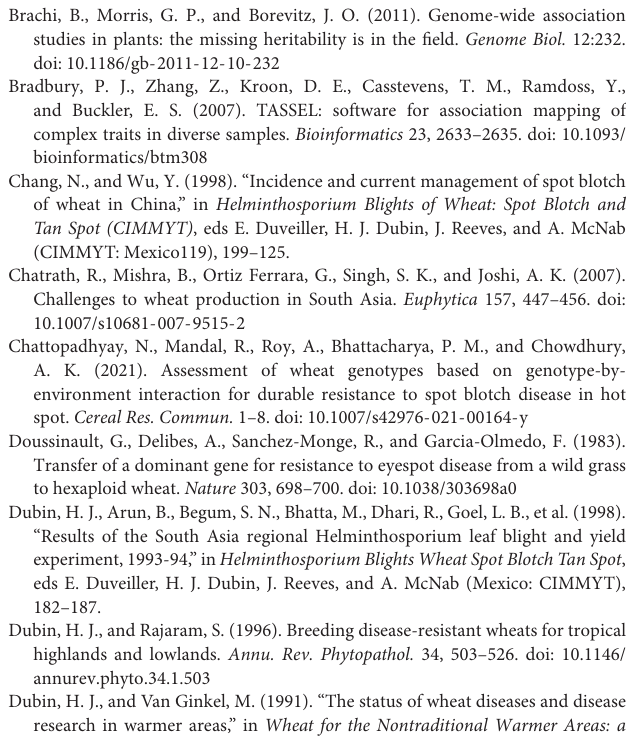
Supplementary Figure 1 | Manhattan plots showing the marker − log 10 p -values and the chromosomal positions for the marker-days to heading associations in genome-wide association mapping in seven panels. The blue line indicates the threshold of 0.001 to declare the significance of markers and selected markers that were significantly associated with days to heading are indicated. Supplementary Figure 2 | Manhattan plots showing the marker − log 10 p -values and the chromosomal positions for the marker-height associations in genome-wide association mapping in seven panels. The blue line indicates the threshold of 0.001 to declare the significance of markers and selected markers that were significantly associated with height are indicated. Supplementary Figure 3 | Linkage disequilibrium between the markers on chromosome 1B. The standardized disequilibrium coefficients ( D (cid:48) ) are shown in the lower-left matrix and correlations between alleles at the two marker loci ( r 2 ) are shown in the upper-right matrix. Supplementary Figure 4 | Linkage disequilibrium between the markers on chromosome 2A. The standardized disequilibrium coefficients ( D (cid:48) ) are shown in the lower-left matrix and correlations between alleles at the two marker loci ( r 2 ) are shown in the upper-right matrix. Supplementary Figure 5 | Linkage disequilibrium between the markers on chromosome 3B. The standardized disequilibrium coefficients ( D (cid:48) ) are shown in the lower-left matrix and correlations between alleles at the two marker loci ( r 2 ) are shown in the upper-right matrix. Supplementary Figure 6 | Linkage disequilibrium between the markers on chromosome 5B. The standardized disequilibrium coefficients ( D (cid:48) ) are shown in the lower-left matrix and correlations between alleles at the two marker loci ( r 2 ) are shown in the upper-right matrix. Supplementary Figure 7 | Linkage disequilibrium between the markers on chromosome 7D. The standardized disequilibrium coefficients ( D (cid:48) ) are shown in the lower-left matrix and correlations between alleles at the two marker loci ( r 2 ) are shown in the upper-right matrix.